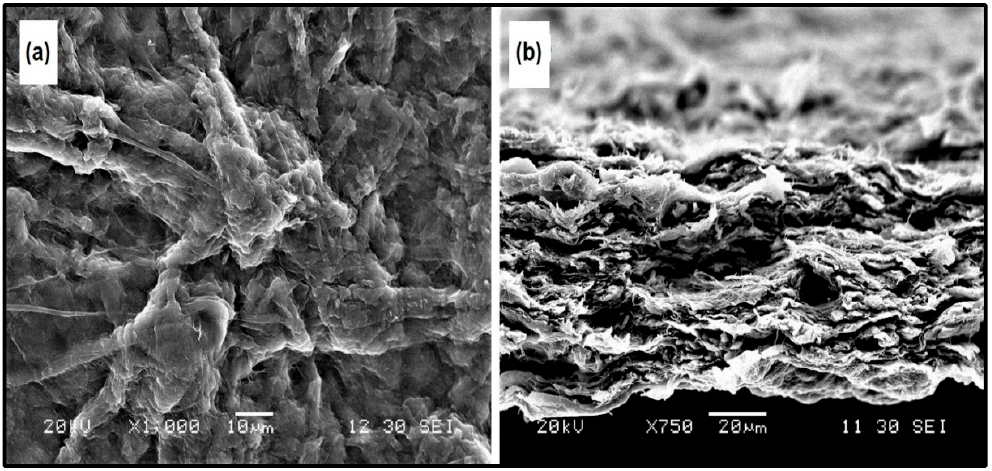
Figure 9. SEM image of ( a ) surface of cellulose nanopaper, and ( b ) cross-section of cellulose nanopaper.